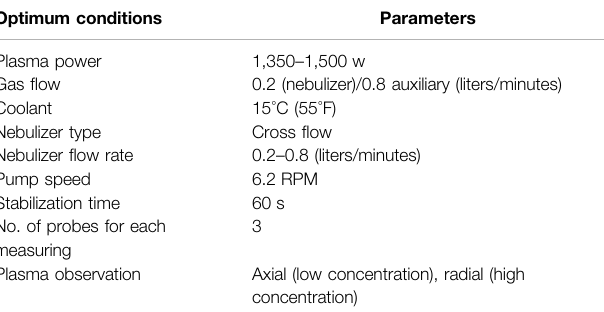
TABLE 1 | Plasma speci fi cation and optimum conditions for ICP-OES. Optimum conditions Parameters Plasma